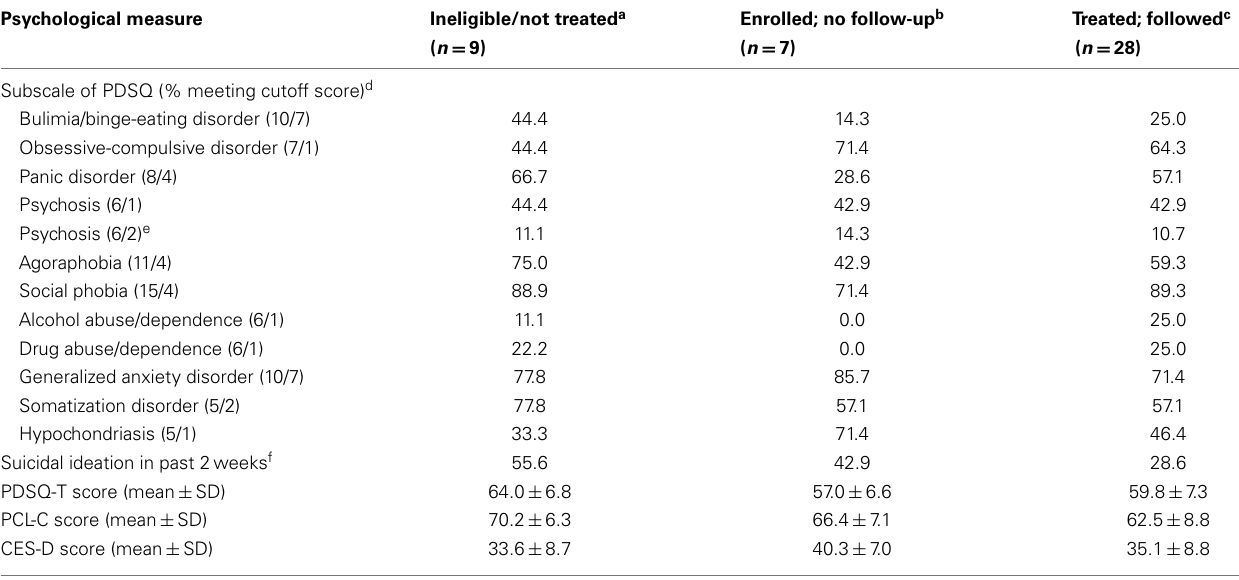
Table 1 | Psychological status of screened consenting individuals with evidence of clinically significant PTSD and depression.